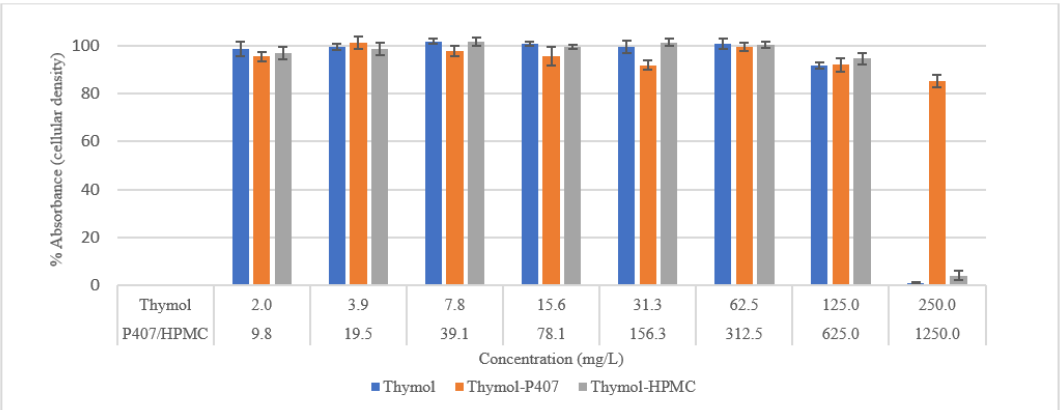
Figure 9. Effect of thymol on the viability of HEK293 cells, 2-h exposure, measured using a Sulforho- damine B assay. Each point represents the mean percentage ± SE, n = 9.